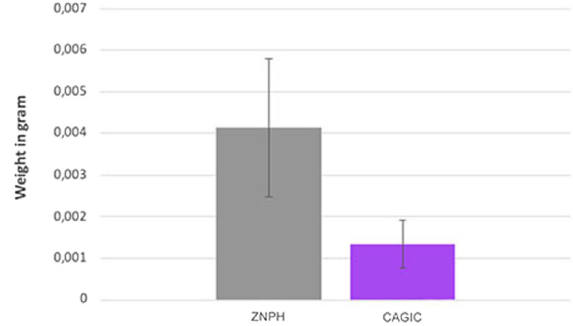
Fig. 9 Results of weighing. Mean weight of remaining cement excess for ZNPH and CAGIC, with 95% con fi dence